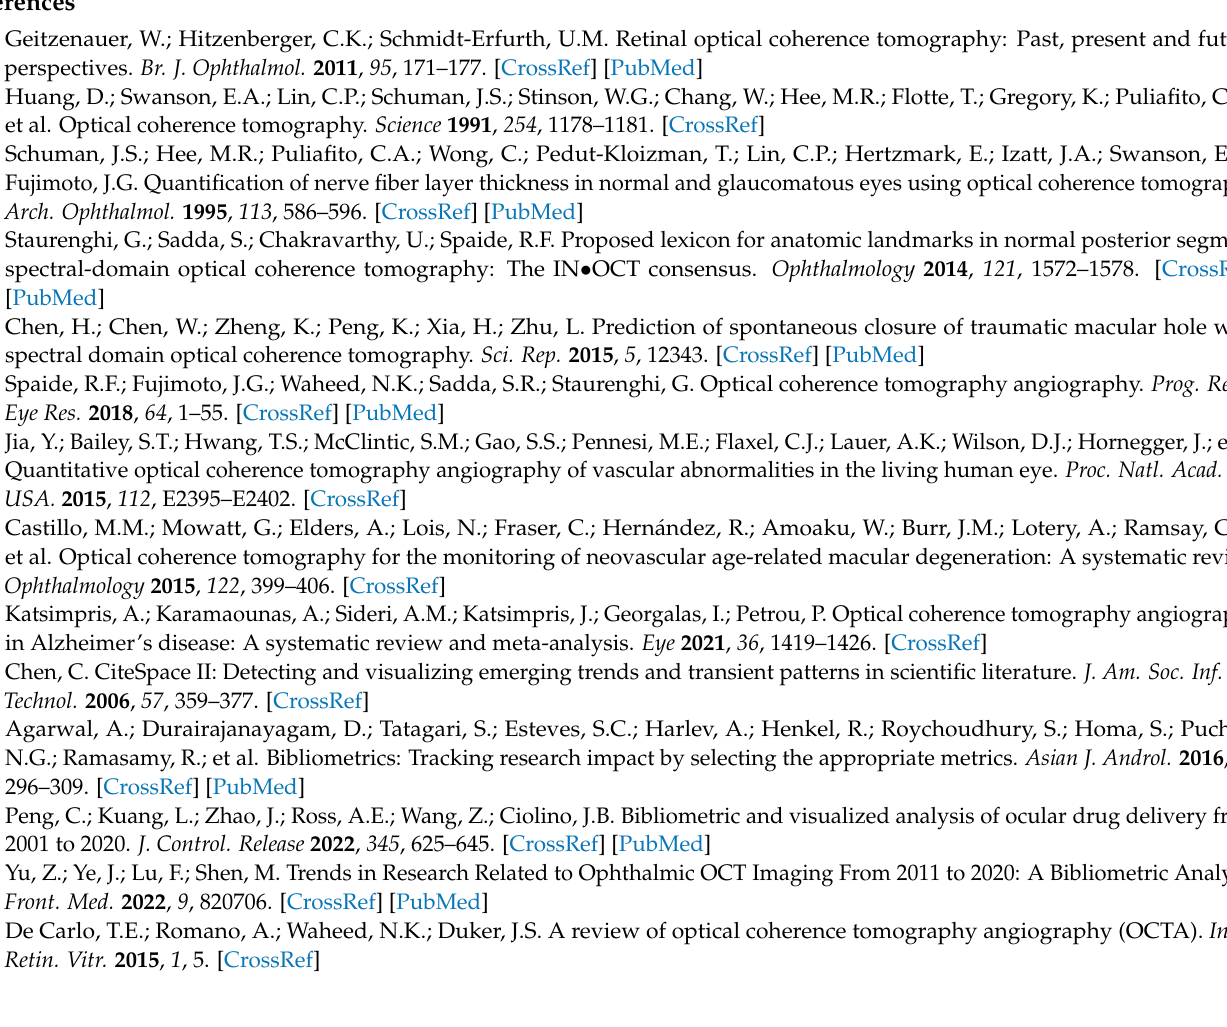
Table S2: Cluster 2 of the top 100 keywords; Table S3: Cluster 3 of the top 100 keywords; Table S4: Cluster 4 of the top 100 keywords; Table S5: Cluster 5 of the top 100 keywords; Table S6: Details of clusters; Figure S1: Co-occurrence analysis of the top 100 keywords. (A) Co-occurrence network